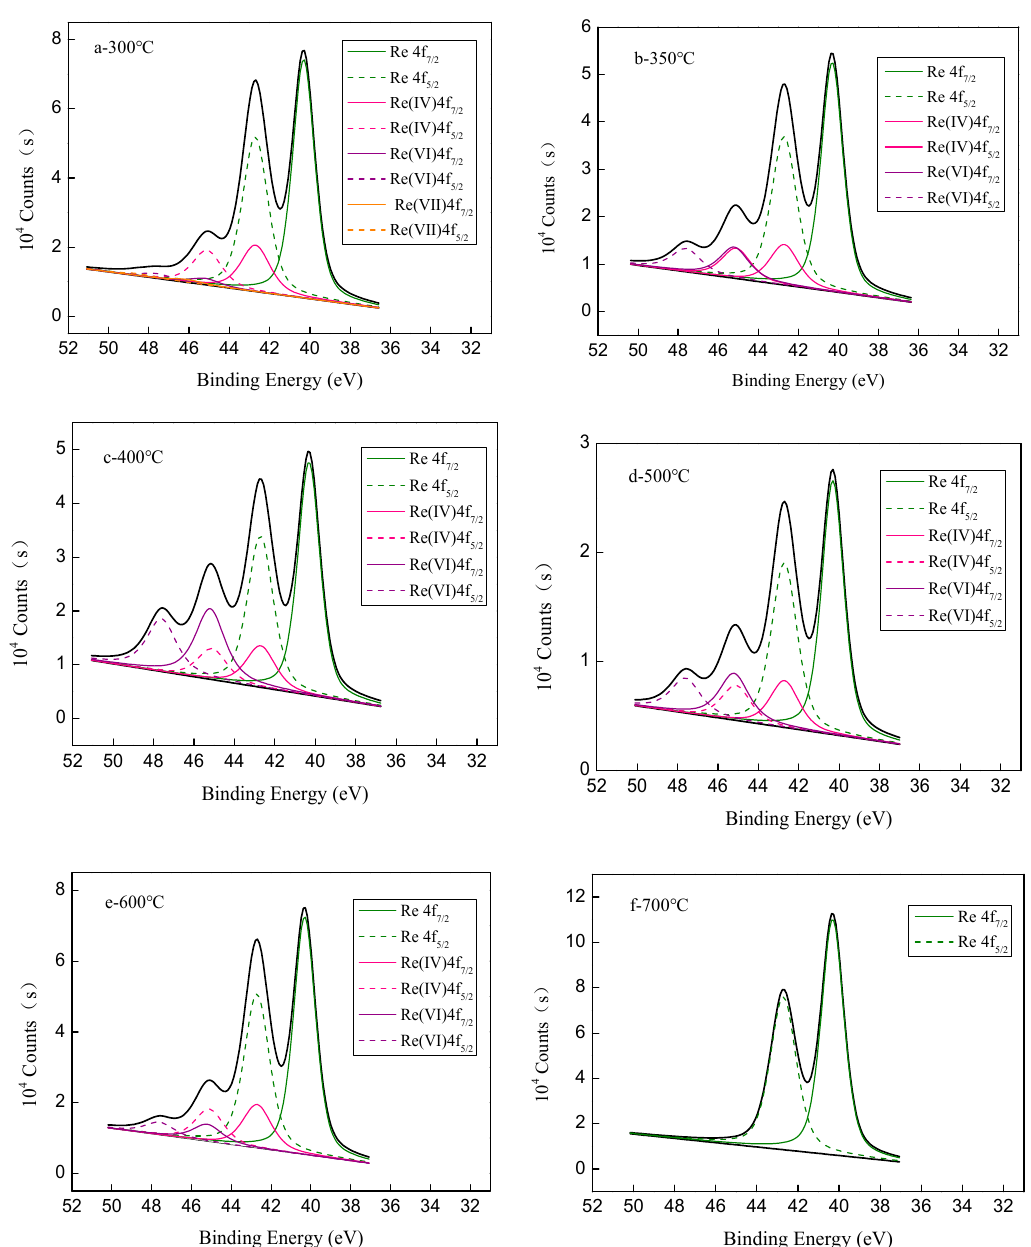
Figure A1. X-ray photoelectron spectroscopy of the reduction products of ammonium perrhenate (D 50 was 71.17 µm, specific surface was 26.93 m 2 /kg) at different temperatures.